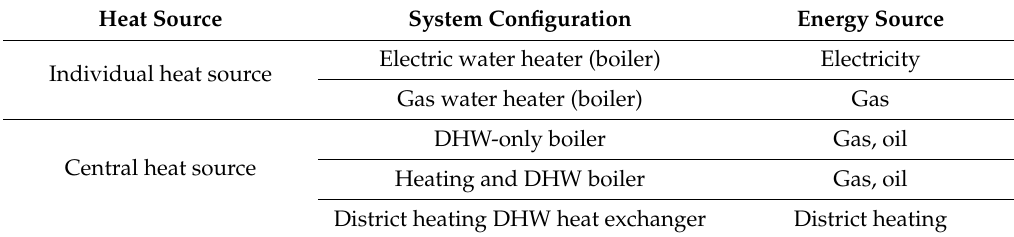
Table A3. Examples of DHW